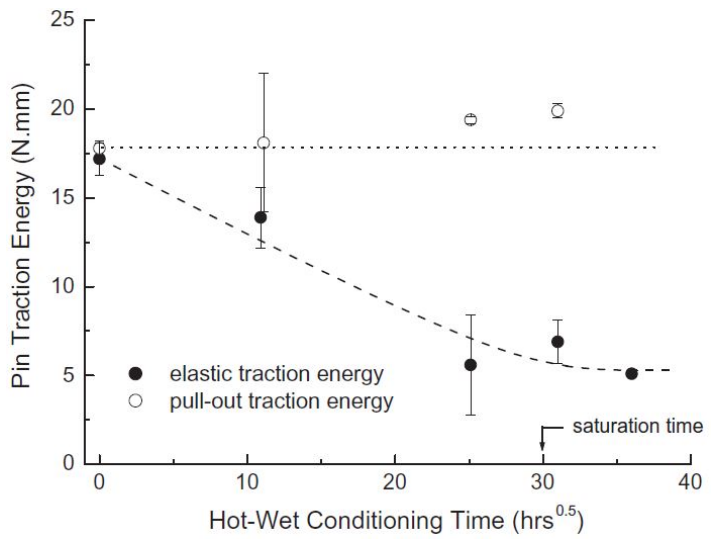
Figure 36. E ff ect of hot-wet conditioning (70 ◦ C and 85% humid) on elastic and pull-out traction energy of z-Pins (CFRP z-Pins, 2.0 vol%, d = 0.28 mm, [0 / 90] pre-preg, t = 4.3 mm)